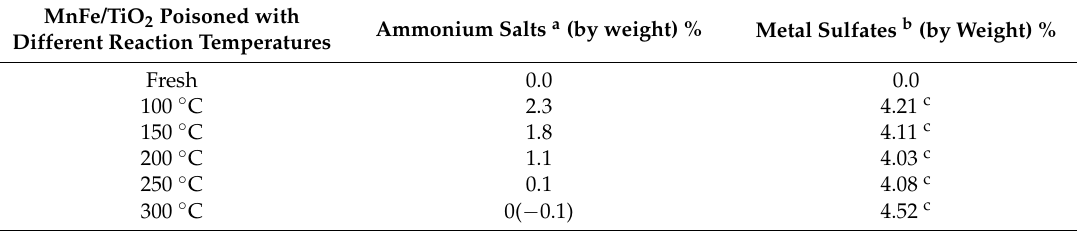
Table 1. Amounts of ammonium salts and metal sulfates deposited on the catalyst surfaces. MnFe/TiO 2 Poisoned with Different Reaction